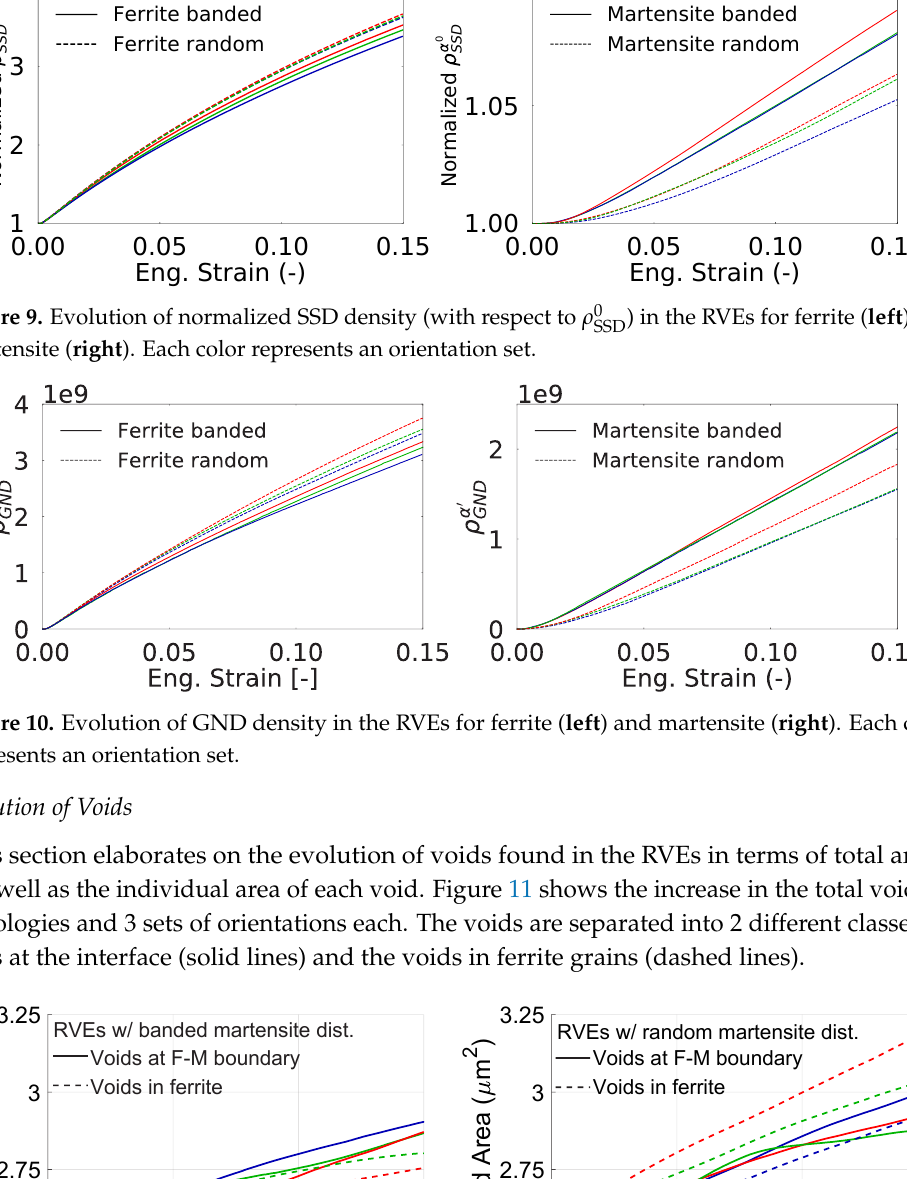
) in the RVEs for ferrite ( left ) and SSD